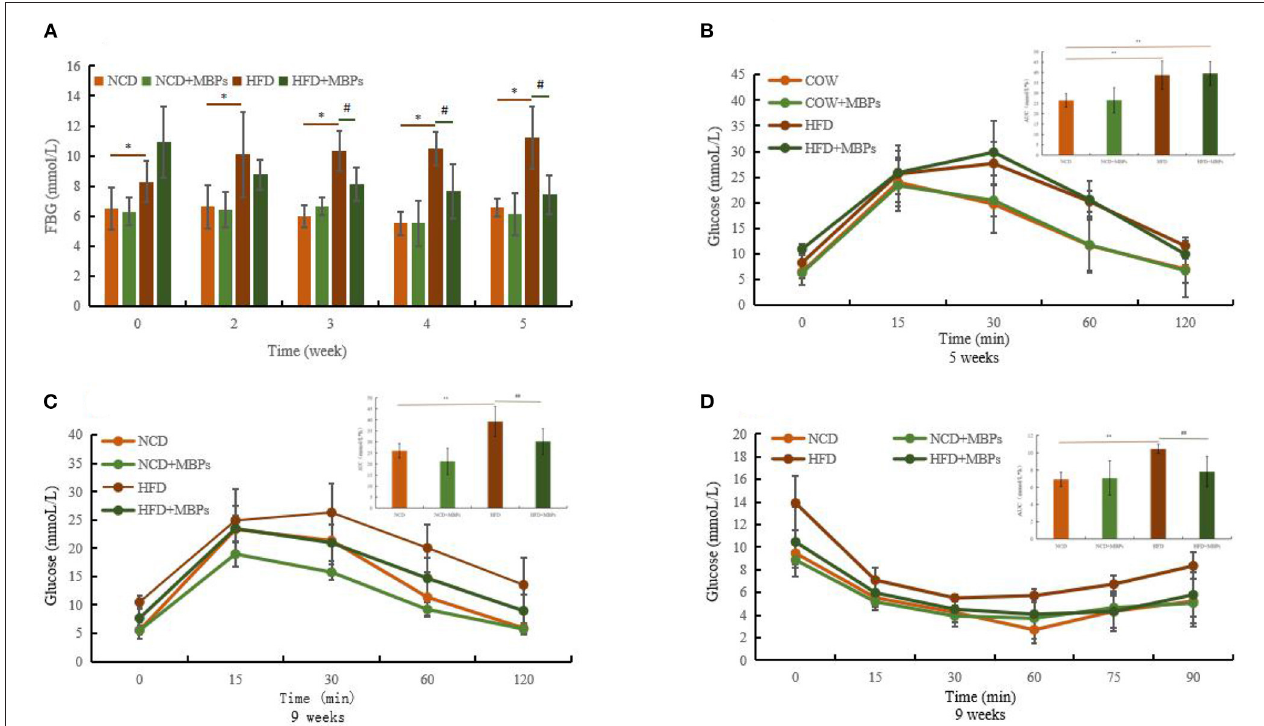
FIGURE 3 | Effects of MBPs on (A) FBG, (B) IPGTT (5 weeks) and AUC, (C) IPGTT (9 weeks) and AUC, (D) IPITT (9 weeks) and AUC. Data were presented as the mean ± SD ( n = 10). * P < 0.05, ** P < 0.01, NCD compared with HFD and HFD + MBPs mice. # P < 0.05, ## P < 0.01, HFD compared with HFD + MBPs